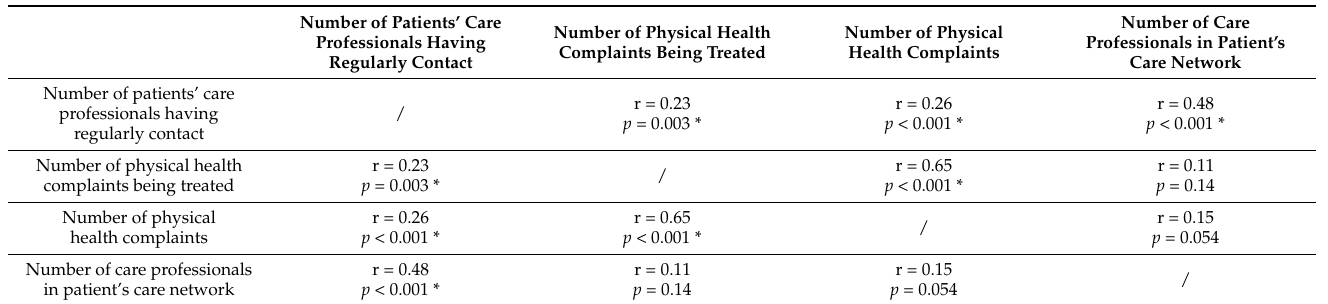
Table 5. Correlations between number of physical health complaints, physical health complaints being treated, number of care professionals having regular contact with patient and number of care professionals involved (Spearman’s rank correlation coefficient and significance level, * = signifi- cant